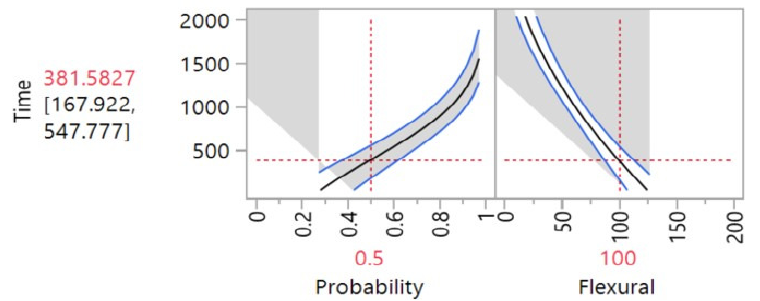
Figure 4. Intersection point in time-degradation: flexural.